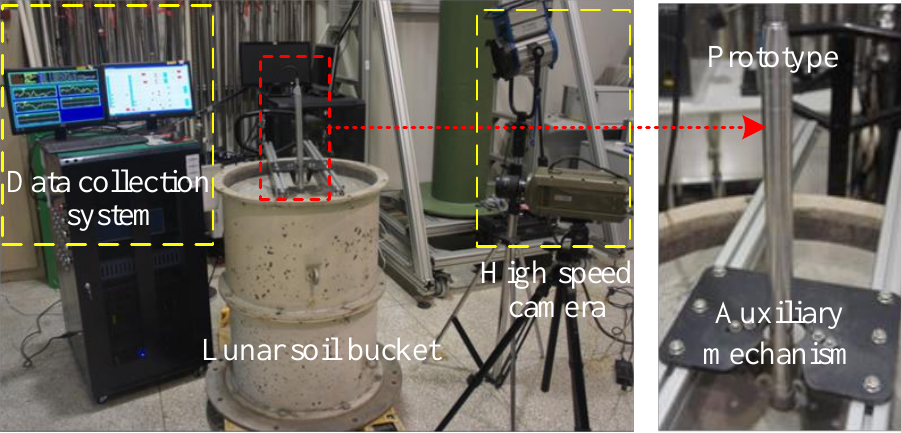
Figure 13. The penetration efficiency experiment platform.